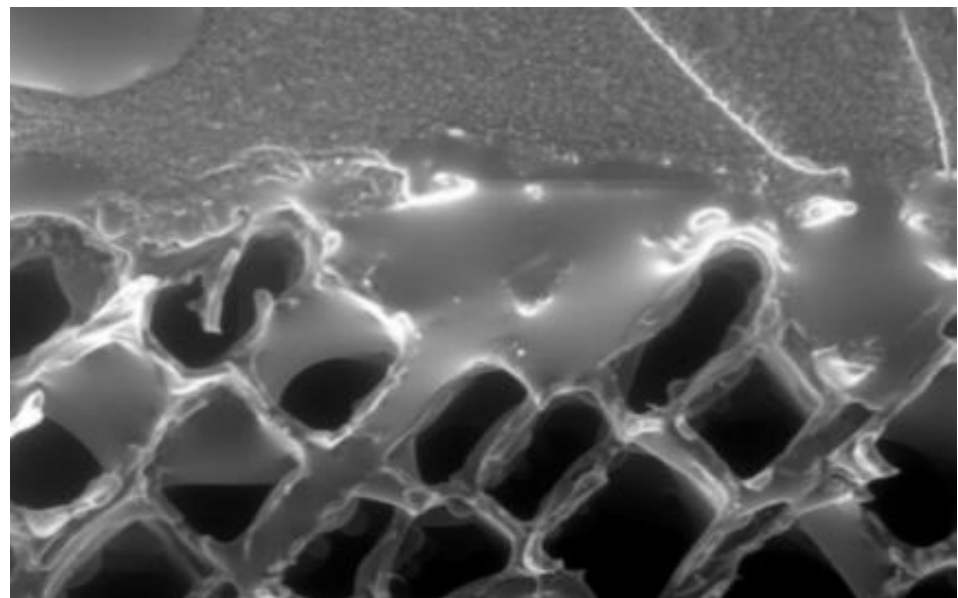
Figure 15. penetration of an adhesive into the wood surface. Figure 15. Penetration of an adhesive into the wood